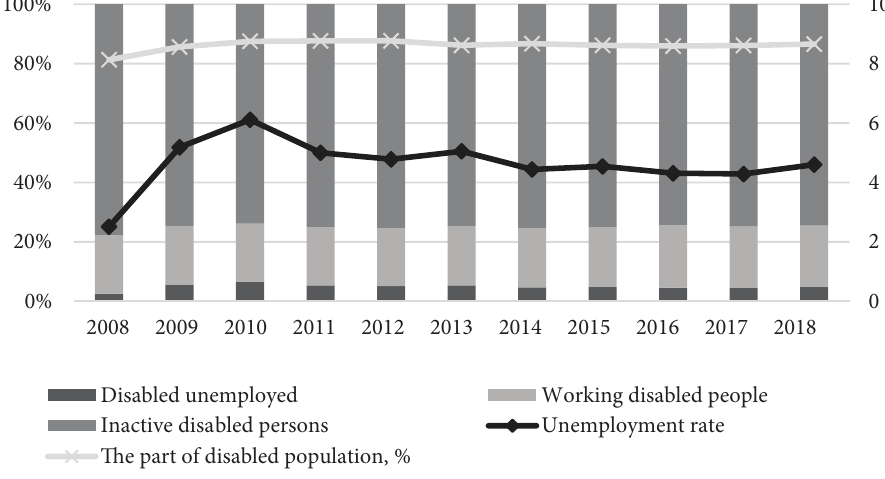
Figure 3. Dynamics of disabled people in Lithuania, per cent. (source: created by authors, based on Employment service, 2018; Ministry of Social Security and Labour,